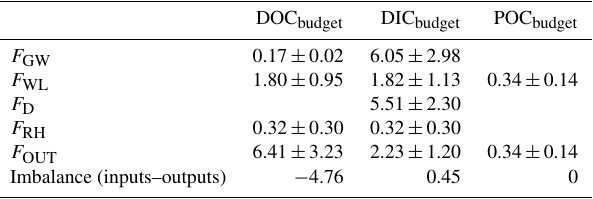
Table 5. DOC, DIC and POC budgets in the first-order Mengong stream (Eqs. 8–10). Fluxes are in MgCyr − 1 and are described in detail in Sect. 2.5. Briefly, F GW is the quantity of dissolved car- bon leached from non-flooded forest groundwater to the Mengong stream (Eq. 11), F WL is the quantity of carbon leached from the Mengong wetland to the Mengong stream (Eqs. 13–14), F D is the quantity of CO 2 degassed from the Mengong stream to the atmo- sphere, F RH is the heterotrophic respiration in the Mengong stream and F OUT is the quantity of carbon hydrologically exported at the outlet of the Mengong stream.